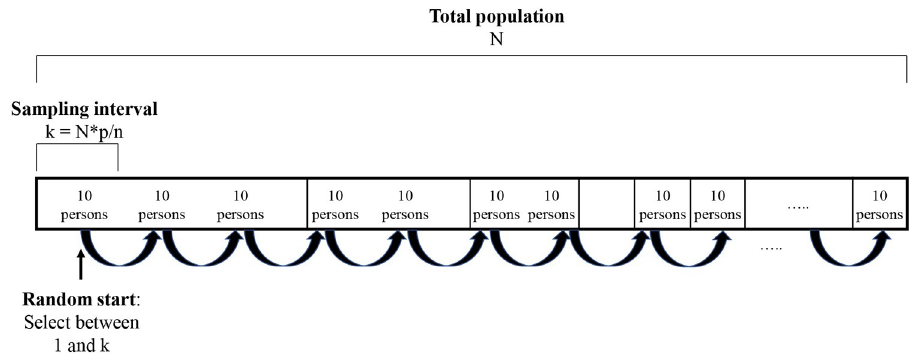
Fig 2. Sampling scheme for the selection of clusters in which each cluster is represented by a segment proportional to its expected number of attendees with k the sampling interval, p the number of subjects per sample group and n the required sample size. The sum of the segments represents the total population